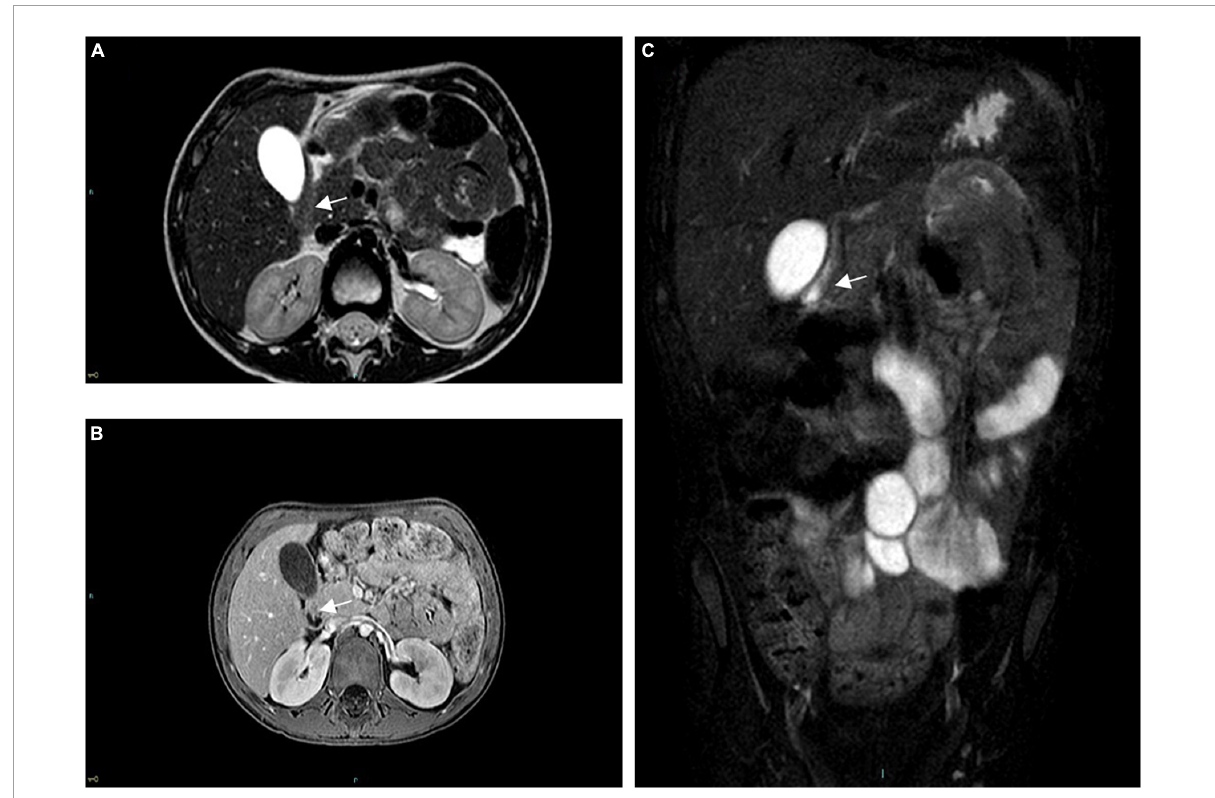
FIGURE2 Pre-operative abdominal MRI. (A) Axial TSE-T2w, (B) axial GRE-T1w, and (C) coronal turbo-spin echo T2w FAT-SAT sequences are shown, all demonstrating a thickened and narrowed pylorus (arrow), without a visible